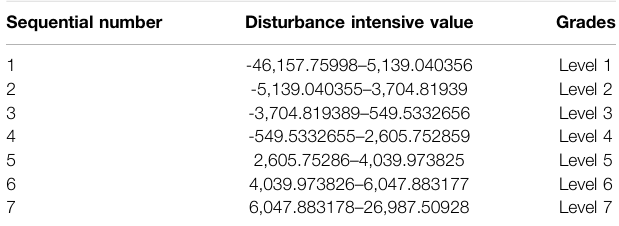
TABLE 3 | The results can be divided into seven levels according to the intensity value of disturbance. Sequential number